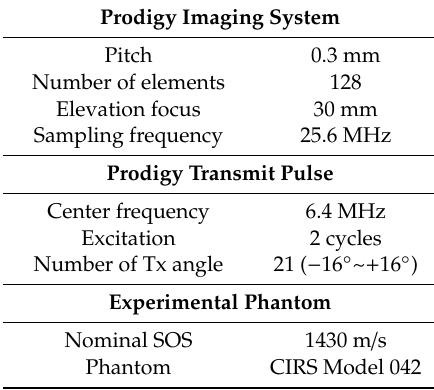
Table 2. The parameter of Prodigy ultrasonic imaging system